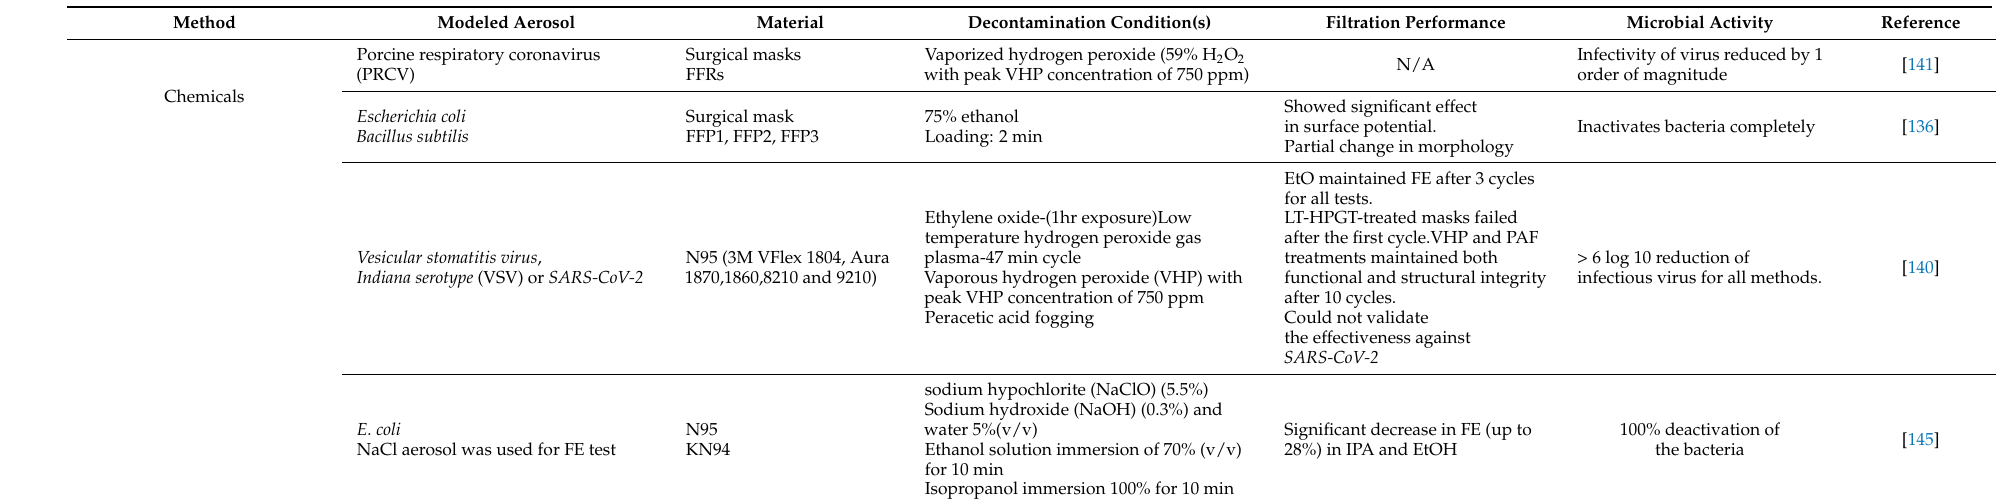
Table 13. Decontamination and regeneration using chemicals.